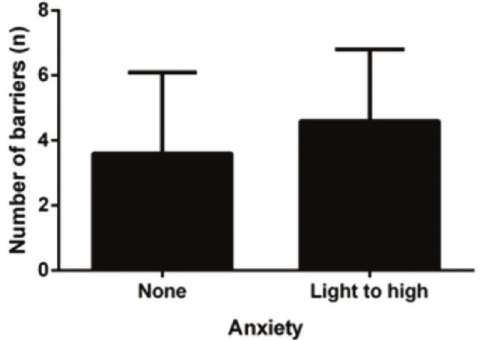
Fig 3 - Comparison of the number of barriers according to the anxiety